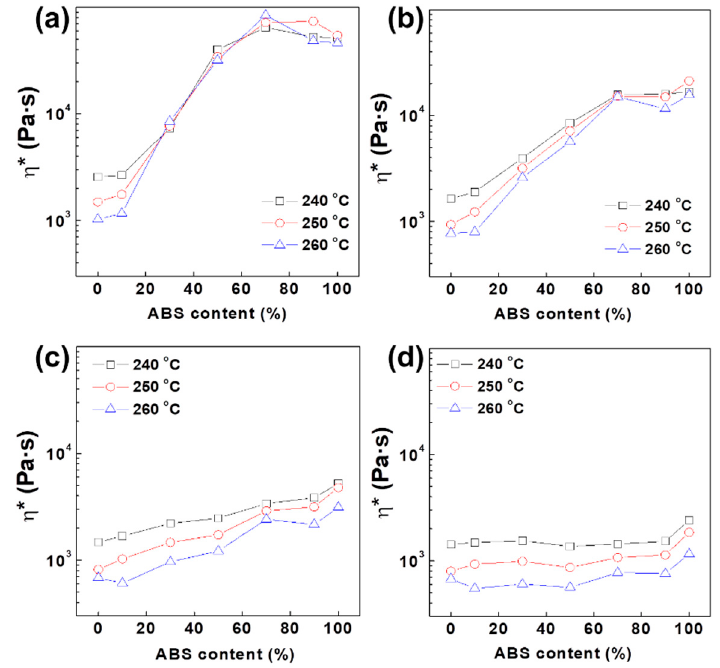
Figure 2. E ff ect of temperature on viscosity of PC / ABS blends at given frequency of ( a ) 0.01, ( b ) 0.1, Figure 2. Effect of temperature on viscosity of PC/ABS blends at given frequency of ( a ) 0.01, ( b ) 0.1, ( c ) 1 and ( d ) 10 rad / ( c ) 1 and ( d ) 10 rad/s.